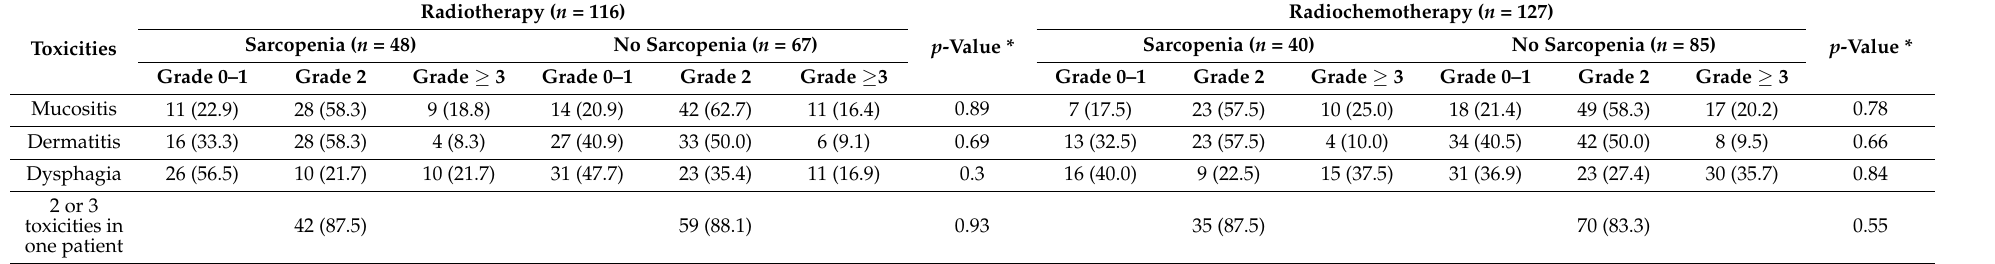
Table 2. Acute toxicities according to treatment and